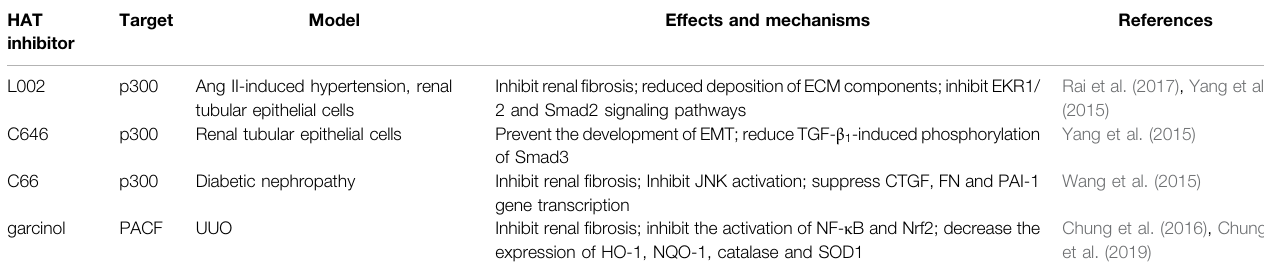
TABLE 1 | Effects of HAT inhibitors on renal fi brosis.